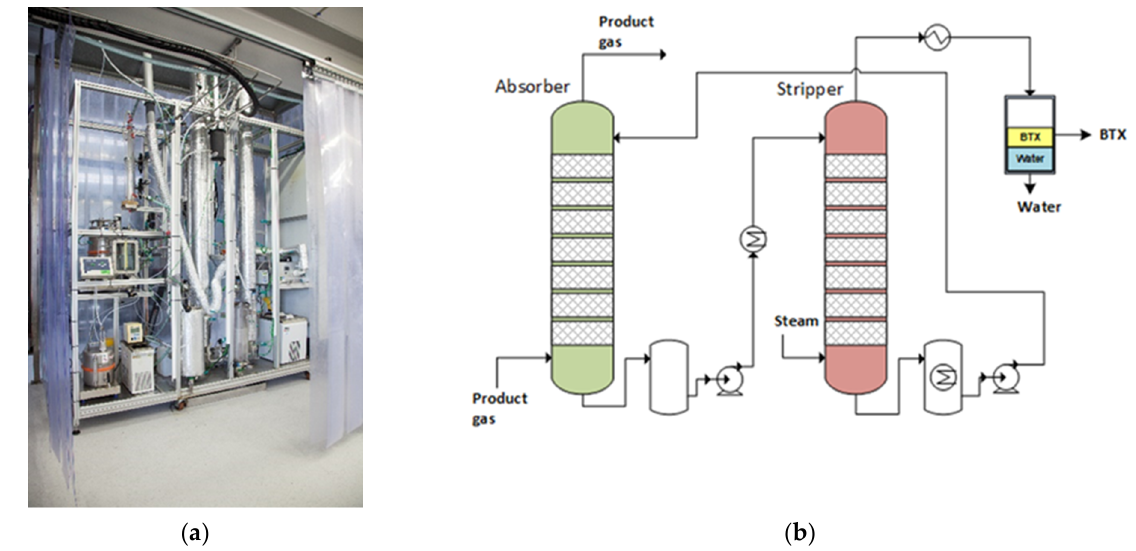
Figure 5. AREA-1 before scale-up: ( a ) AREA-1 at TNO; ( b ) process flow diagram of AREA-1. The stripper gas containing the steam and BTX is allowed to condense after which phase separation between the BTX and water occurs, as shown in Figure 6. This automated process has been comprehensively detailed elsewhere [19]. The regenerated oil is cooled to the absorber temperature and sent back to the absorber. The operating pressure during the whole process is atmospheric.